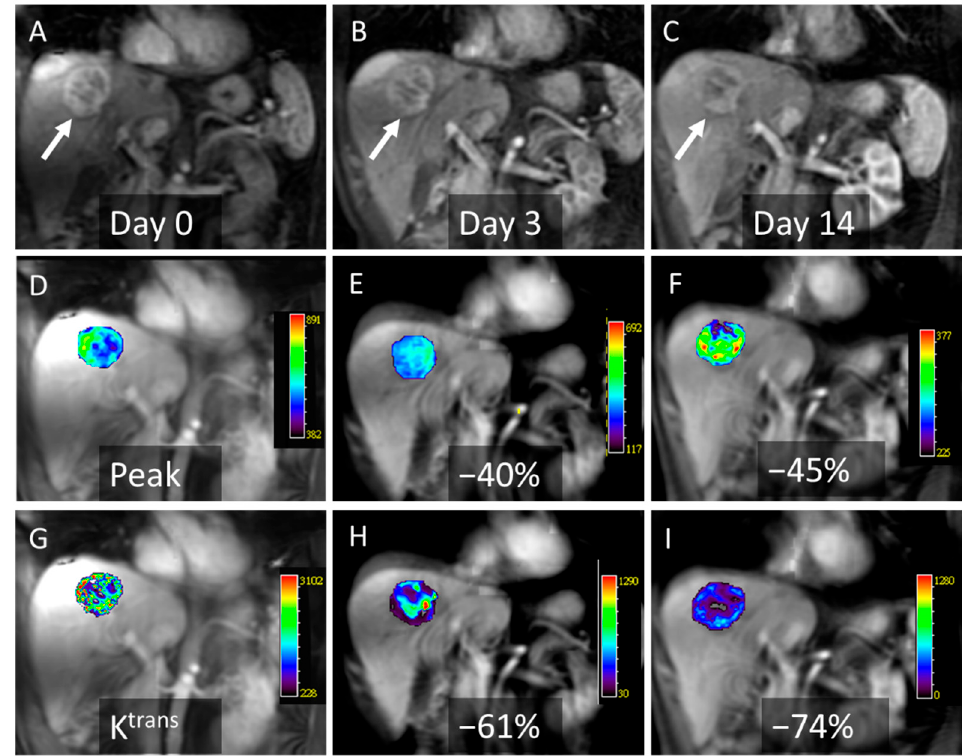
Figure 2. Images from a 51-year-old man who received axitinib with a progression-free survival of 0.9 months and an overall survival of 13 months. ( A ) A coronal contrast-enhanced T1-weighted image depicting a hepatocellular carcinoma in the right upper lobe (arrow) on day 0 (baseline, A ), day 3 ( B ), and day 14 ( C ). Serial changes in Peak compared to the baseline value ( D ) show that there is a marked decrease on day 3 ( − 40%, ( E )) and day 14 ( − 45%, ( F )). Serial changes in K trans also show a marked decrease on day 3 ( − 61%, ( E )) and day 14 ( − 74%, ( F )) when compared to the baseline ( G ).